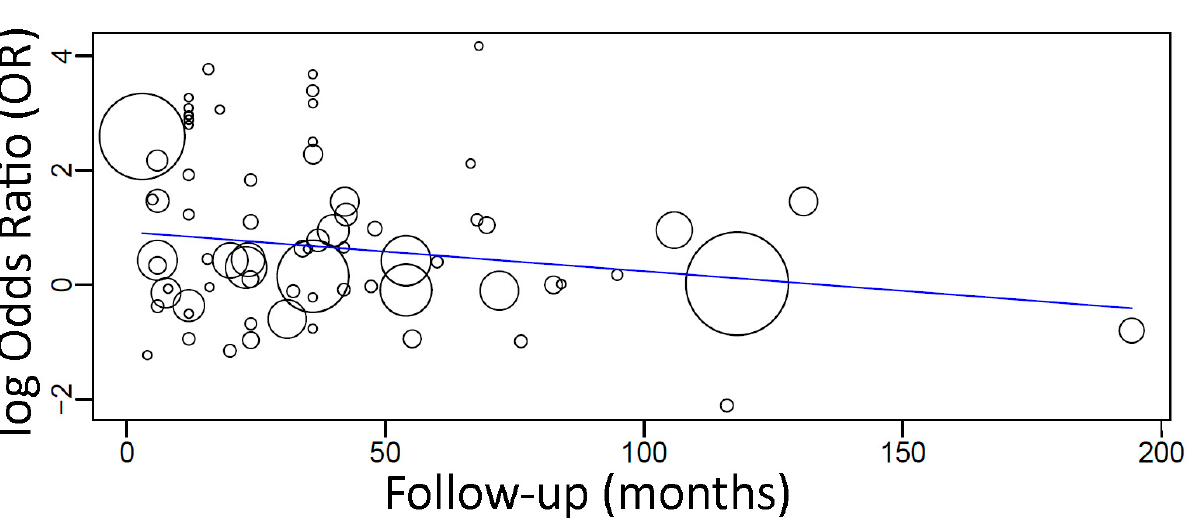
Figure 7. Scatter plot for the meta-regression with the association between the odds ratio (OR) of implant failure between diabetic and non-diabetic individuals, and the follow-up time (in months). Every circle represents a study and the size of the circle represents the weight of the study in the analysis.